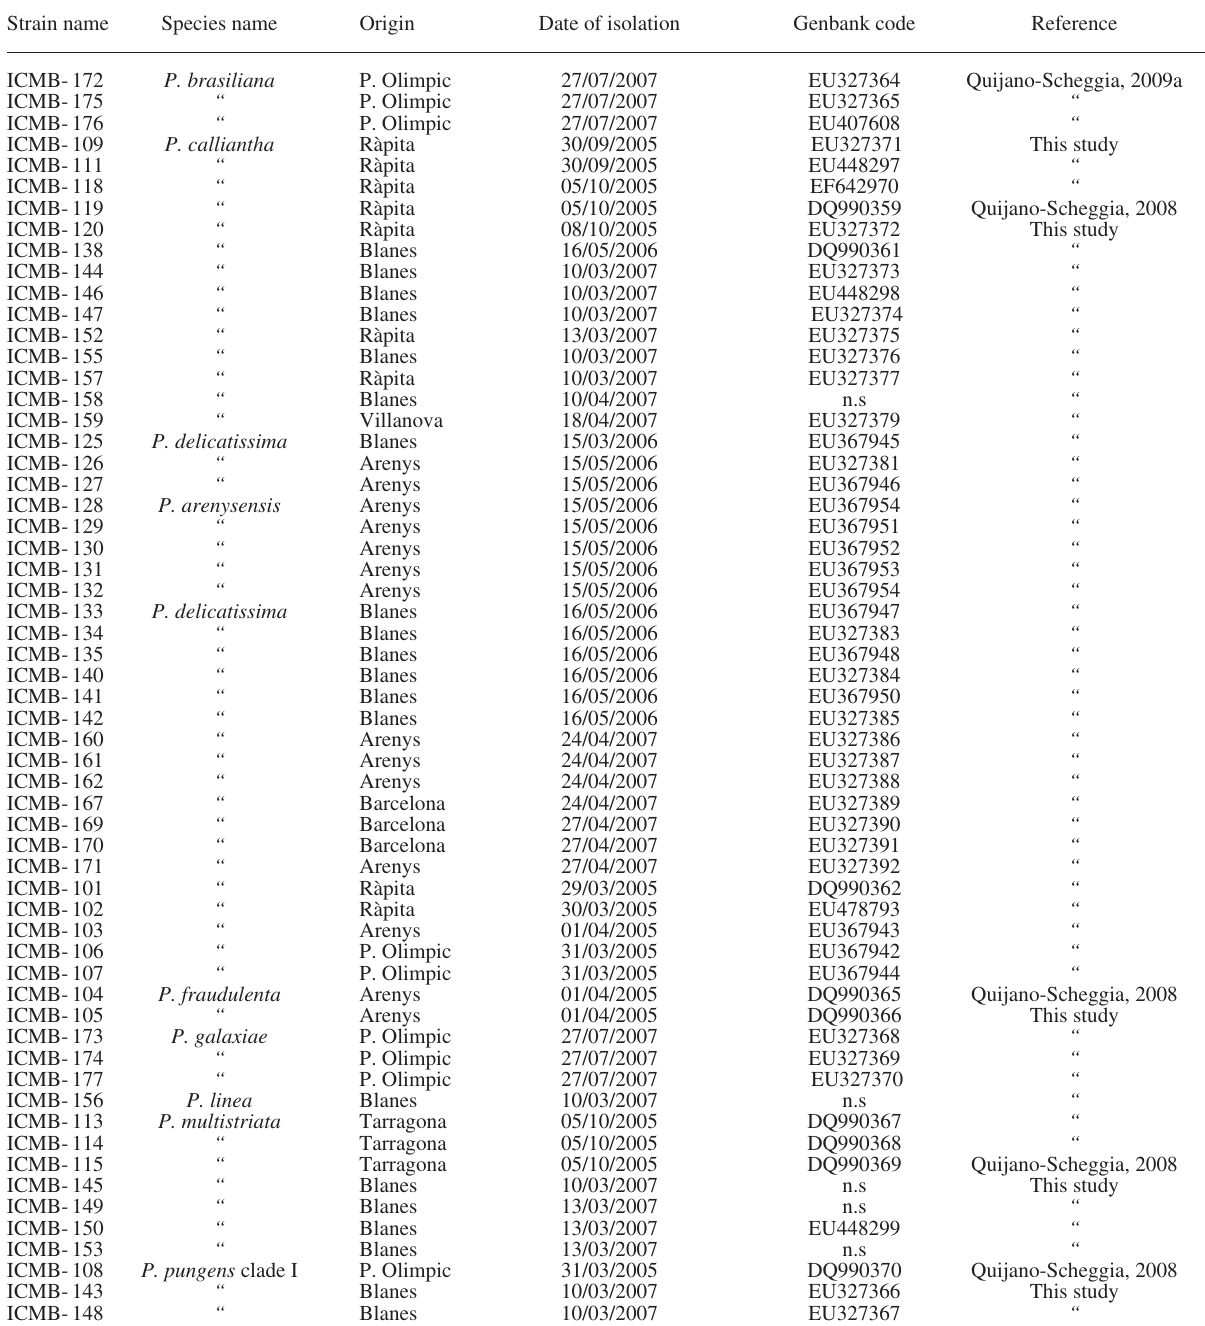
Table 2. – Pseudo-nitzschia strains from the NW Mediterranean Sea used in the phylogenetic analysis and mating compatibility test. Origin, date of isolation and GenBank accession numbers of the different strains. References to other studies that use the strains are